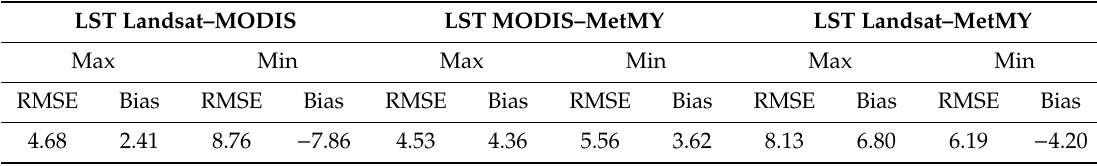
Table 11. RMSE and bias of LST